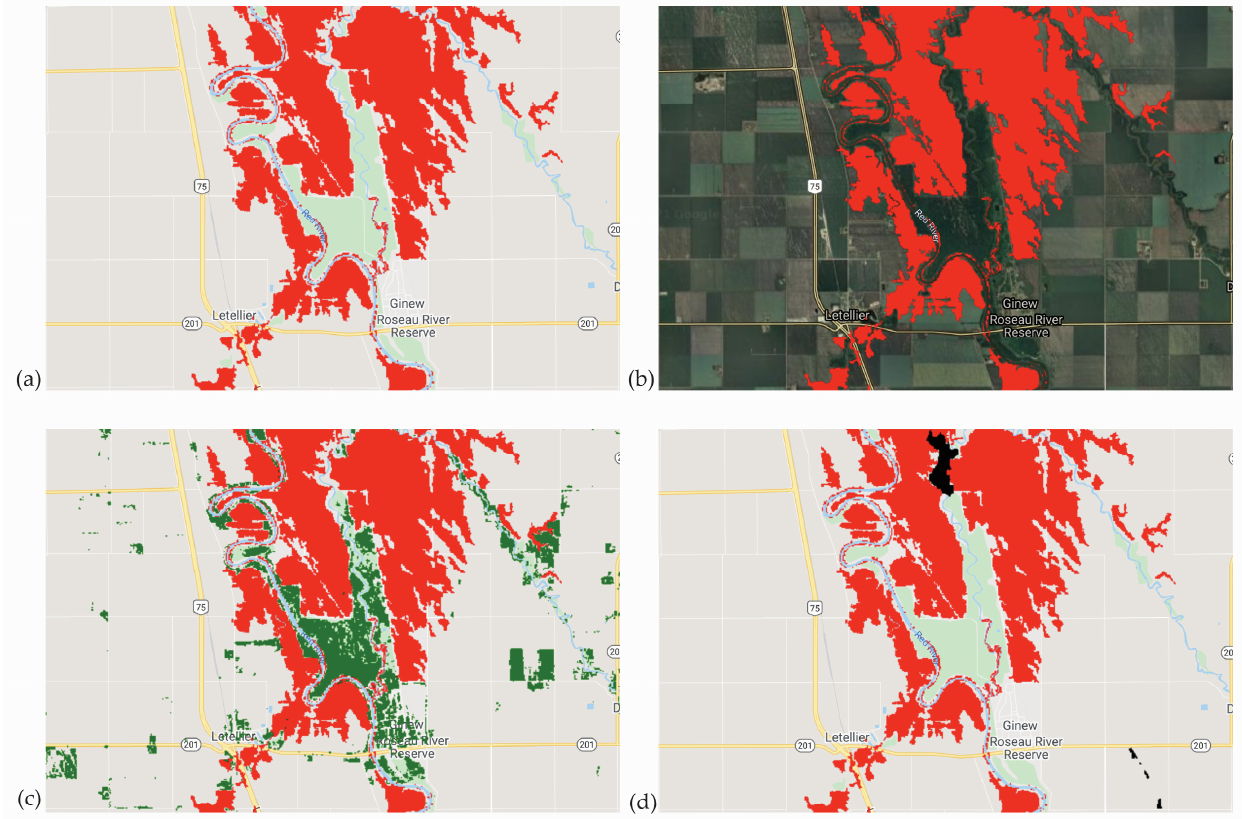
Figure 5. NDVI and HAND mask for 2019 Red River flood. ( a ) reference flood extent with vegetation marked on Google Maps; ( b ) reference flood extent with vegetation visible of satellite imagery; ( c ) reference flood extent with NDVI mask (threshold set at 0.4); ( d ) reference flood extent with HAND mask (threshold set at